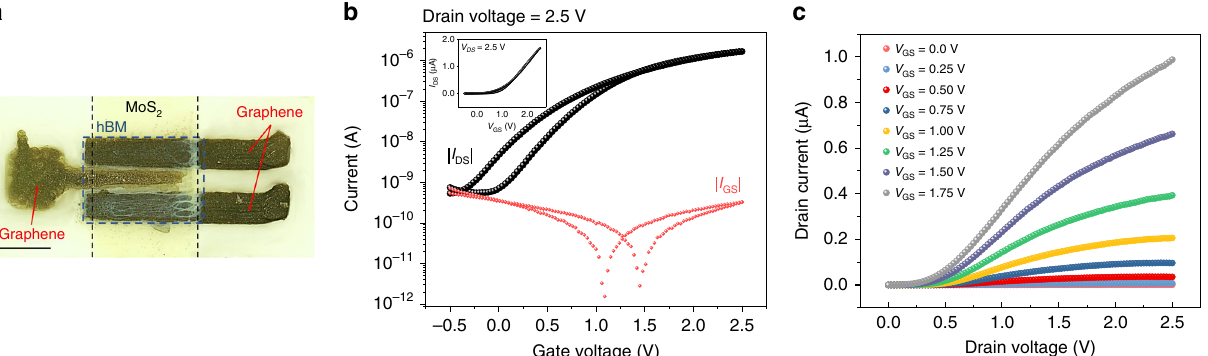
Fig. 3 Optical image and electrical characterization of a fully 2D-material-based FETs. a Optical micrograph of a fully 2D-material-based transistor on paper. The scale bar corresponds to 250 μ m. b Typical transfer characteristic curve measured as a function of the gate voltage for a drain voltage of 2.5 V. Logarithmic scale: black dots, drain current; red dots, gate current. inset, Typical transfer characteristic curve measured as a function of the gate voltage for a drain voltage of 2.5 V in linear scale. c Typical output characteristic curves measured at increasing gate voltages (from V GS = 0.0 V to V GS = 1.75 V, steps of 0.25